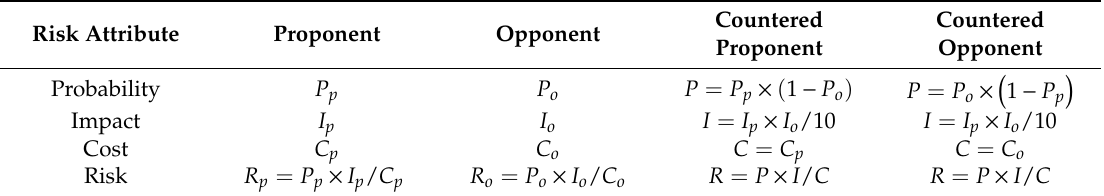
Table 1. Risk vector evaluation rules for countered nodes in